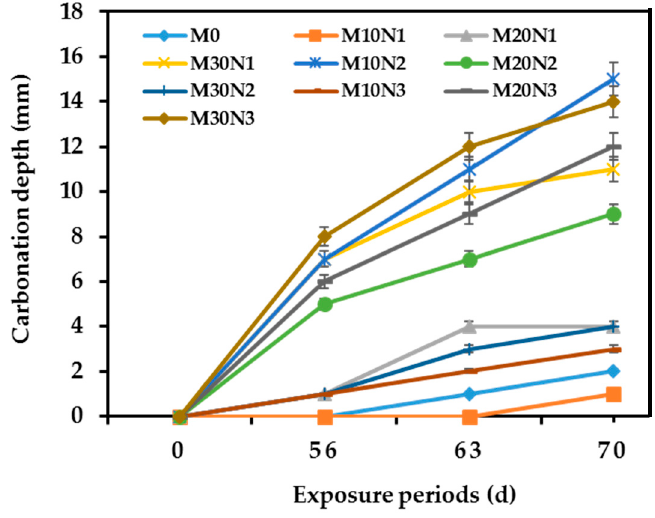
Figure 9. Carbonation depth of different concretes with and without POFA.